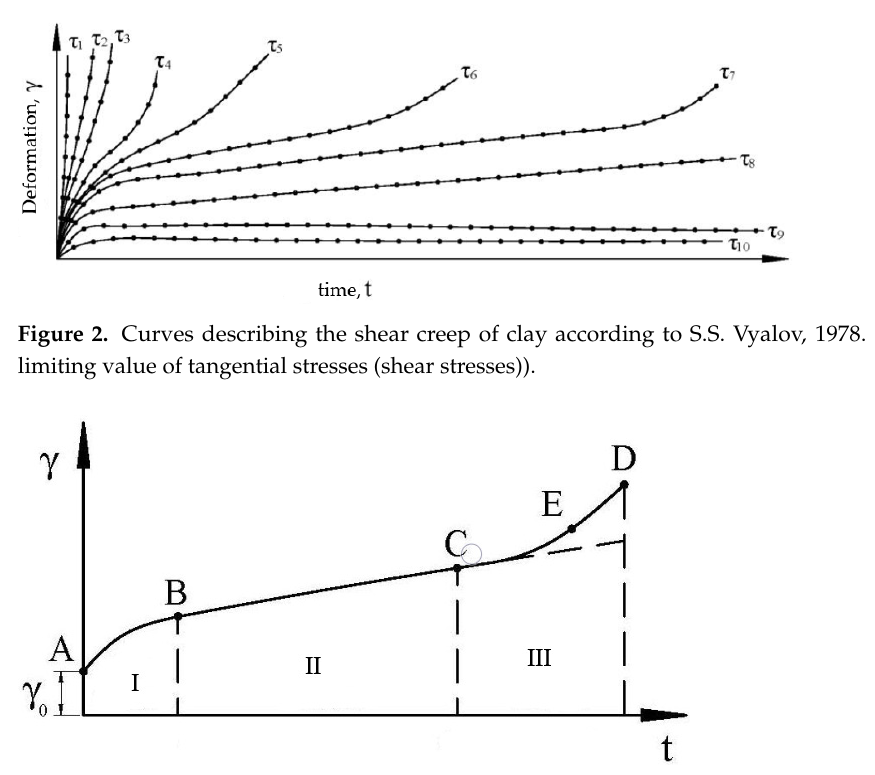
Figure 3. Diagram showing how deformations change over time: Stage I is the stage of steady creep (section AB); Stage II is the stage of a steady flow process (section BC), Stage III is the stage of progressive collapse (section CE). [2].